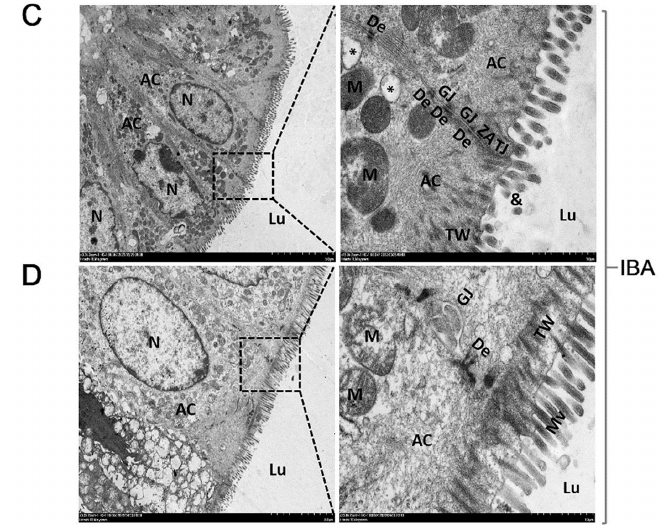
Figure 3. Transmission electron microscopy imaging of colonic mucosal epithelial cells in LT group ( A , B ) and IBA group ( C , D ) of Daurian ground squirrels. Colonic lumen (Lu), absorptive cells (AC), microvilli (Mv), microsomes (&), nucleus (N), mitochondria (M), terminal network (TW), tight junctions (TJ), zonula adherens (ZA), desmosomes (De), gap junctions (GJ). LT, late torpor; IBA, interbout arousal.